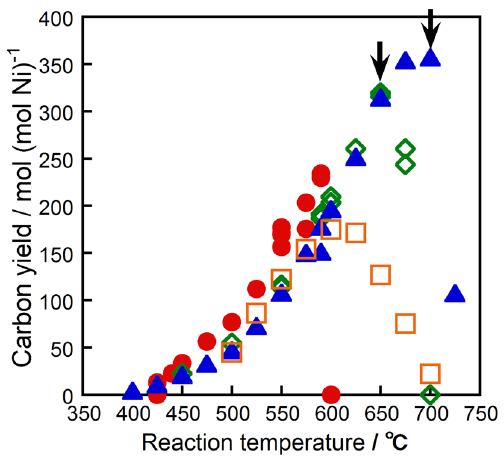
Fig. 2 The relation between the reaction temperature and the carbon yield of the Marimo-like carbon growth using the Ni–Cu– bimetal catalyst with the Cu ratio of 0% (solid circle mark), 20% (open rhombus mark), 50% (solid rectangular mark), and 90% (open square mark),